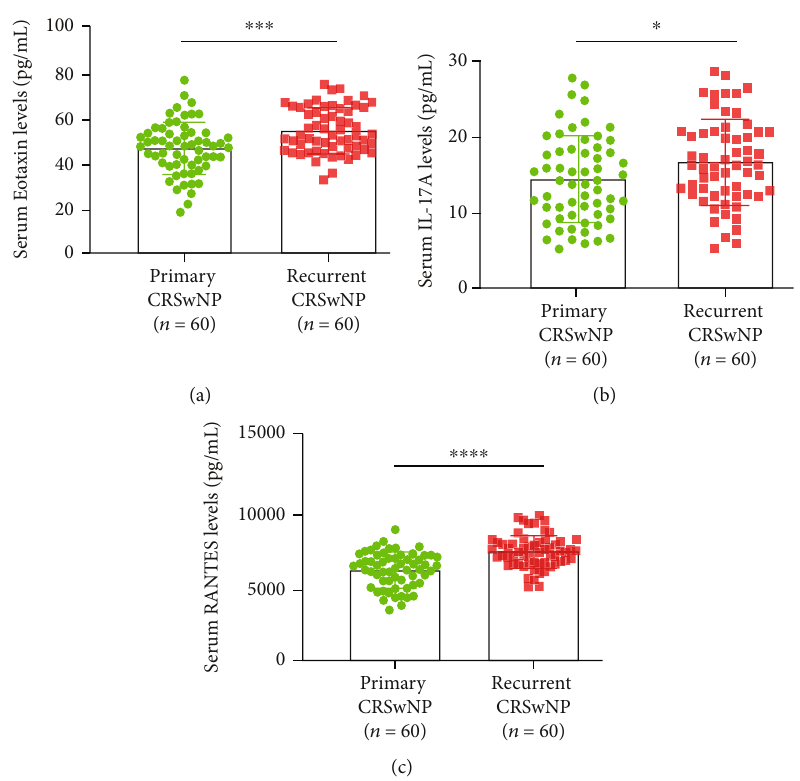
Figure 3: The serum levels of most potential cytokines between primary CRSwNP and recurrent CRSwNP groups in the validation cohort. (a) eotaxin; (b) IL-17; (c) RANTES. CRSwNP: chronic rhinosinusitis with nasal polyps; IL: interleukin; RANTES: regulated upon activation normally T expressed and presumably secreted. ∗ P < 0 : 05 , ∗∗∗ P < 0 : 001